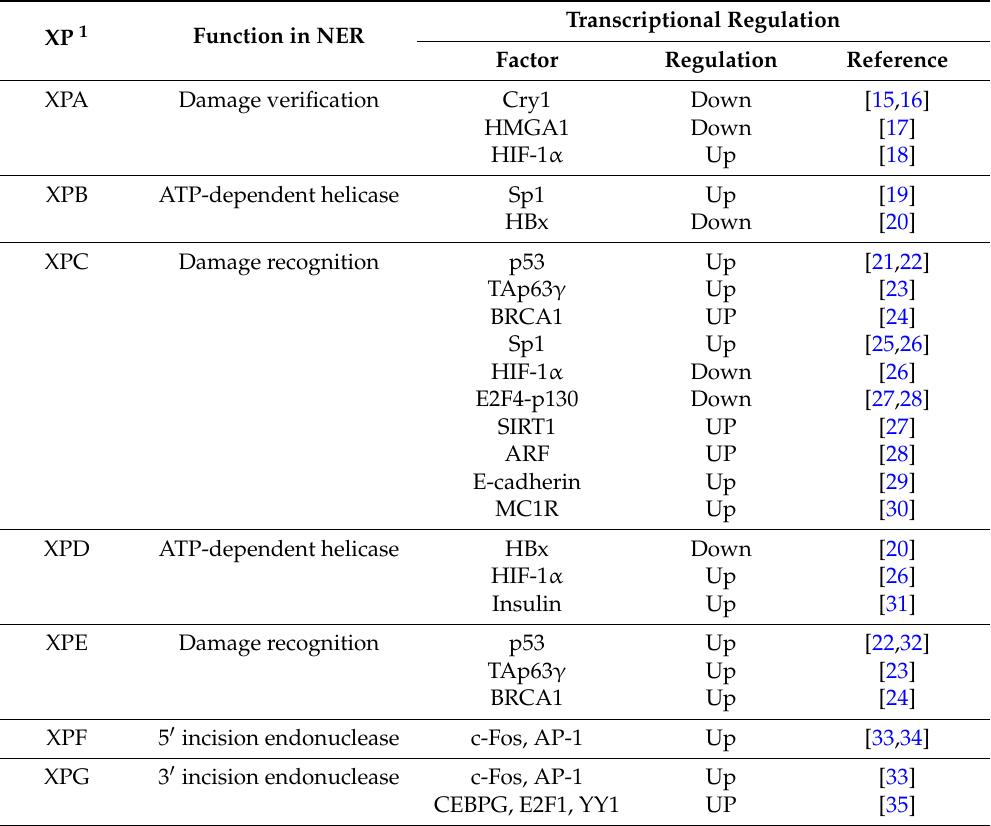
Table 1. A summary of transcriptional regulation of core nucleotide excision repair (NER)